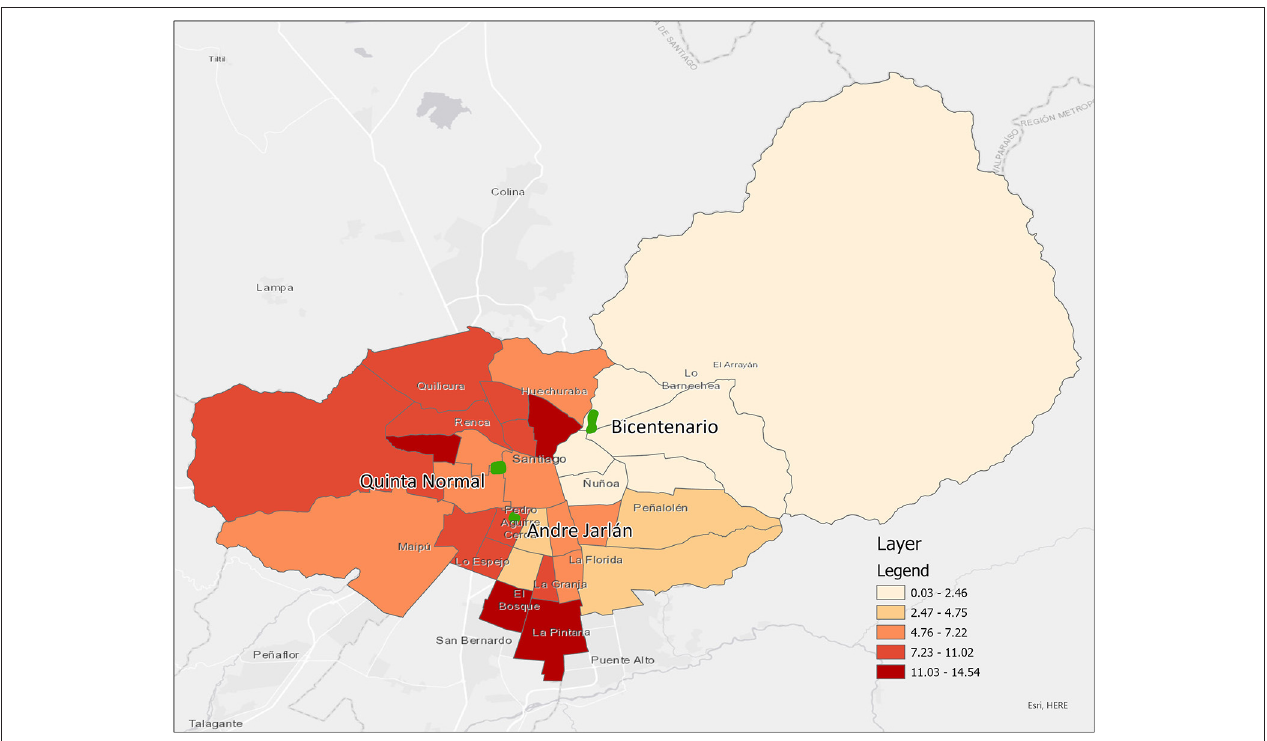
FIGURE 4 | Percentage of population below the poverty line per comuna in Santiago Province (2017).